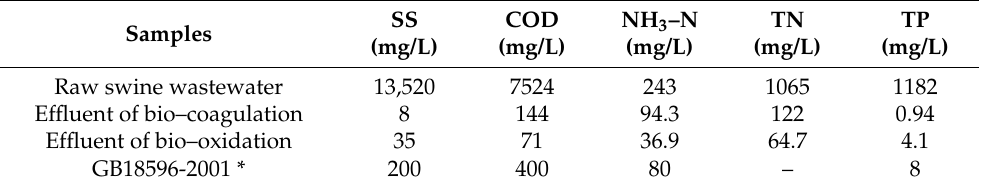
Table 1. The primary properties of swine wastewater before and after various treatments (data provided by Hunan Environment Monitoring Centre, a professional third–party testing body).